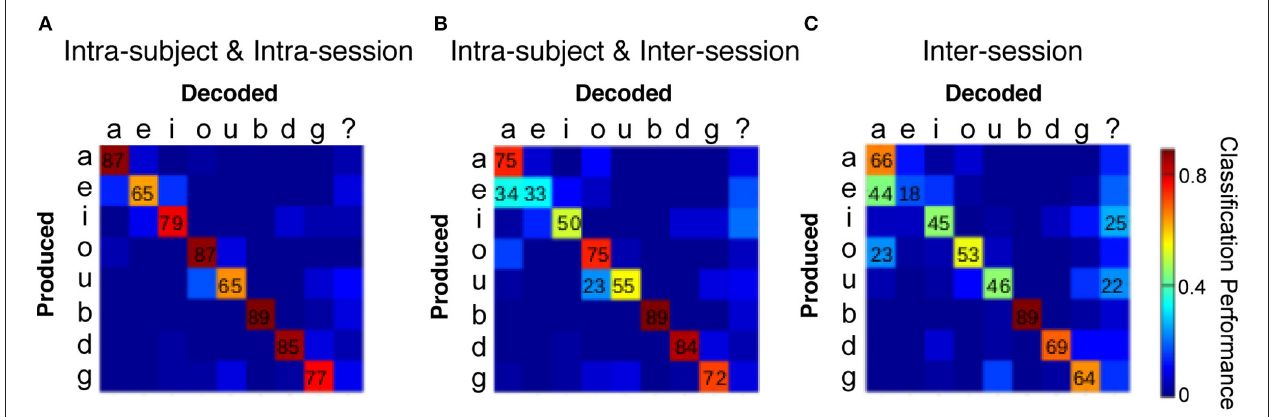
FIGURE 4 | Decoding performance of the discrete representation. (A) Confusion matrix using one set of thresholds per session. Average across sessions and participants. (B) Confusion matrix using one set of thresholds per participant. Average across participants. (C) Confusion matrix computed using one set of thresholds for all participants. Numerical values above 20% are displayed for visualization purposes. Thresholds values and matrix means with standard deviations are shown in Tables S1, S2 , respectively, at Supplementary